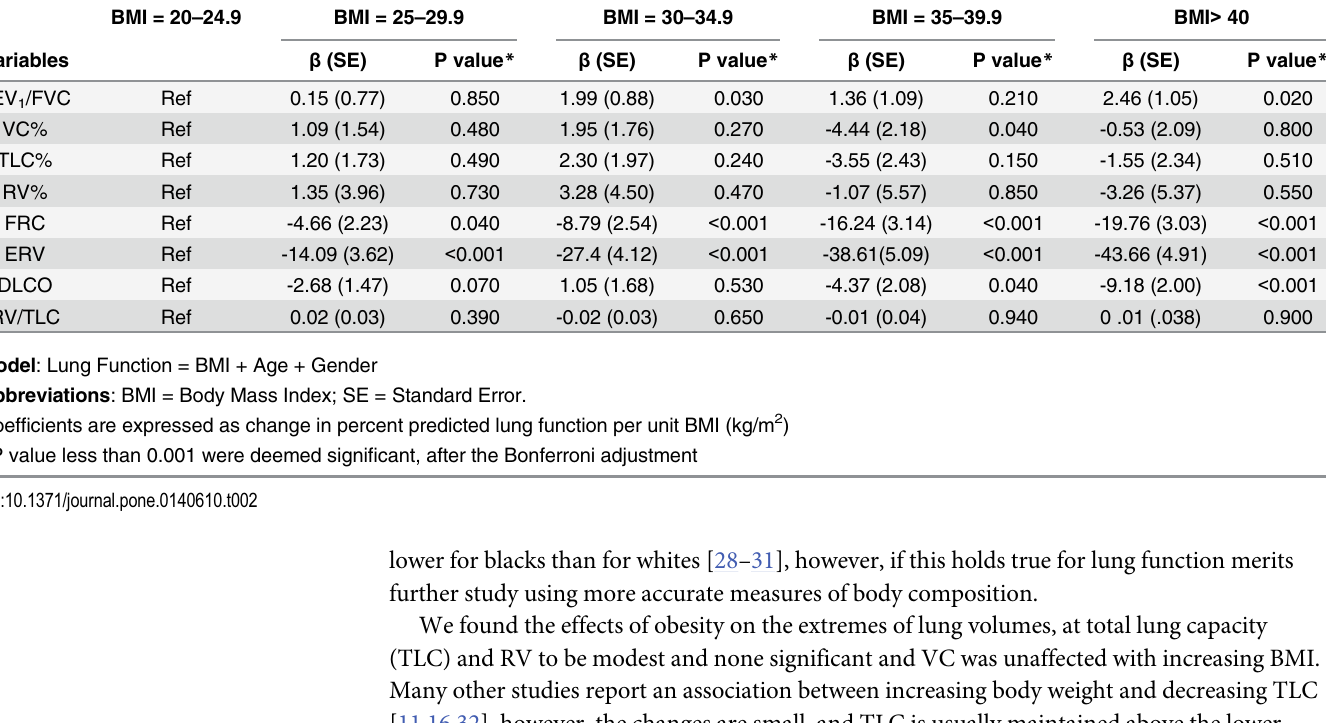
Table 2. Multiple Linear Regressions Modeling for the Association of BMI (kg/m 2 ) and Lung Function. Normal Over Weight Mild Obesity BMI = 20 – 24.9